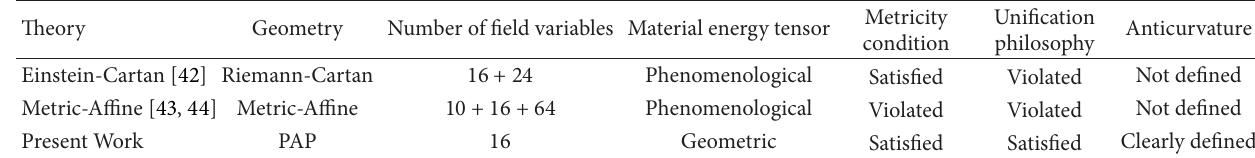
Table 4: Comparison between nonlinear geometric field theories ( 𝑛 = 4 ).